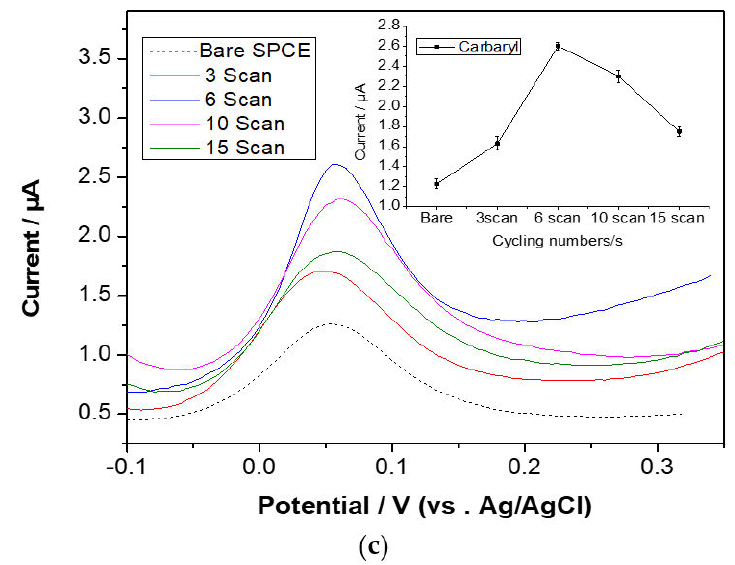
Figure 3. Effect of ( a ) quantity of GO in 5mM HAuCl4 solution and ( b ) concentration of AuNPs in 0.5 mg/mL of GO on 200 µ M carbaryl current. ( c ) The effect of cycling numbers on the oxidation peak of 200 µ M carbaryl; 0.1 M acetate buffer (pH = 5) at rGO/AuNP/NA/